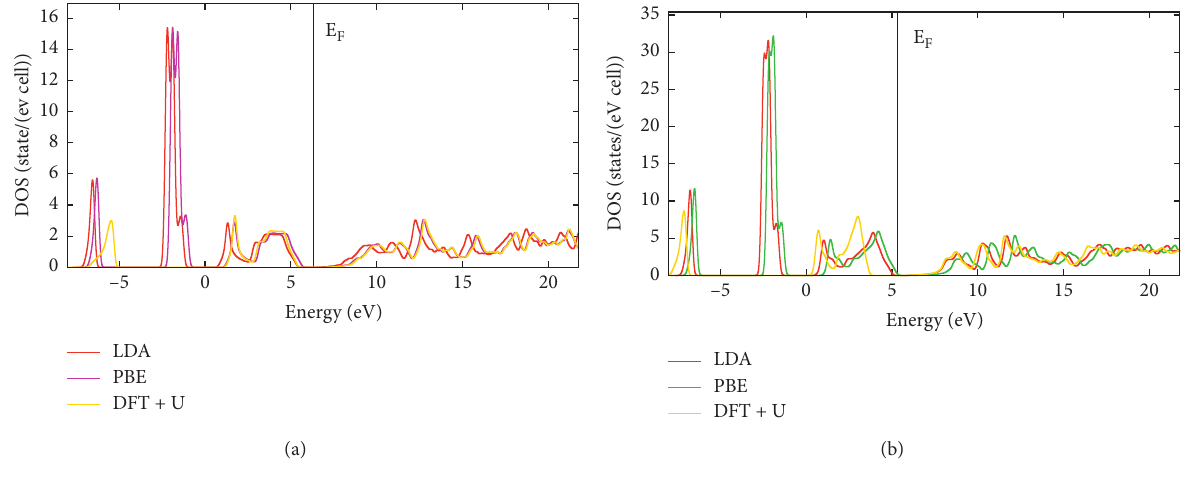
Figure 3: Total density of states of (a) zb-CdS and (b) wz-CdS. Table 2: Comparison of the calculated and experimental